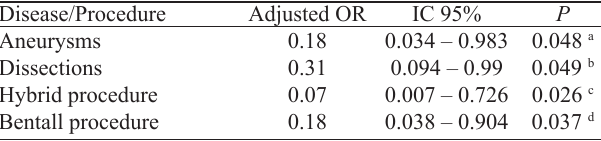
Table 5. Multivariable analysis showing independent association of CTA with reduction of in-hospital mortality. stratified according to group (aneurysms and dissections) and by procedure.